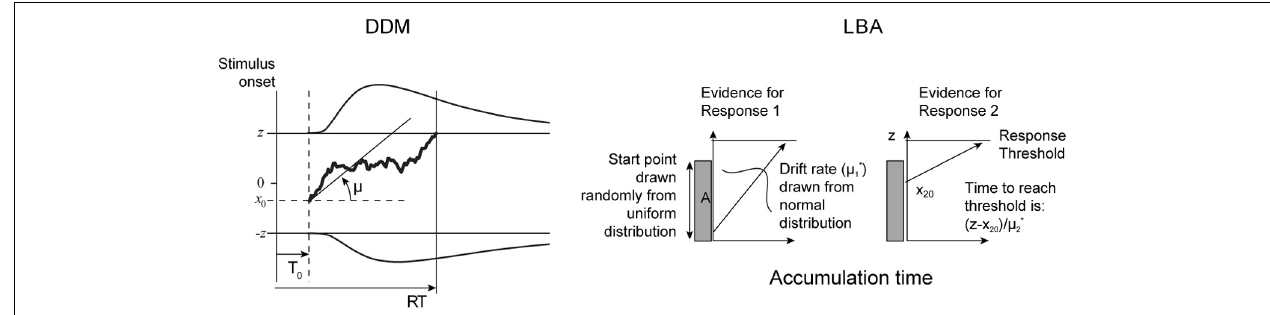
FIGURE 1 | Comparative illustration of pure DDM (left) and LBA (right) models. See text for description of extended DDM and further